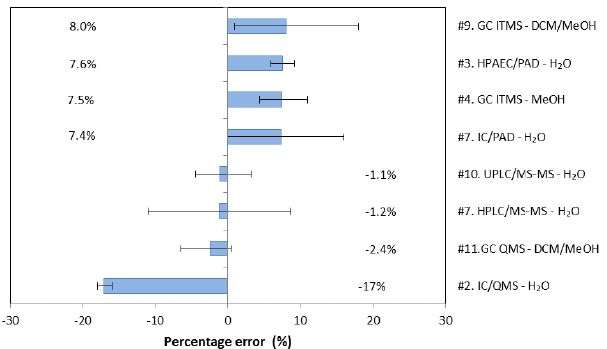
Figure 8. Calculated mean percentage error (PE) for each of the Figure 8: Calculated mean percentage error (PE) for each of the nine laboratories for which the nine laboratories for which the levoglucosan to mannosan ratio levoglucosan to mannosan ratio could be derived. The PE was calculated according to eq. 1 could be derived. The PE was calculated according to Eq. (1) (Section 2.5) for each of the six sectors received by the participating laboratories. The mean PE (Sect. 2.5) for each of the six sectors received by the participating for each laboratory accounts for the PE calculated for all of the six sectors. The laboratory laboratories. The mean PE for each laboratory accounts for the PE number, ranging from 1-13, the analytical method and solvent used for extraction are mentioned calculated for all six sectors. The laboratory number, ranging from at the right of the figure. 1 to 13, the analytical method and solvent used for extraction are mentioned at the right of the